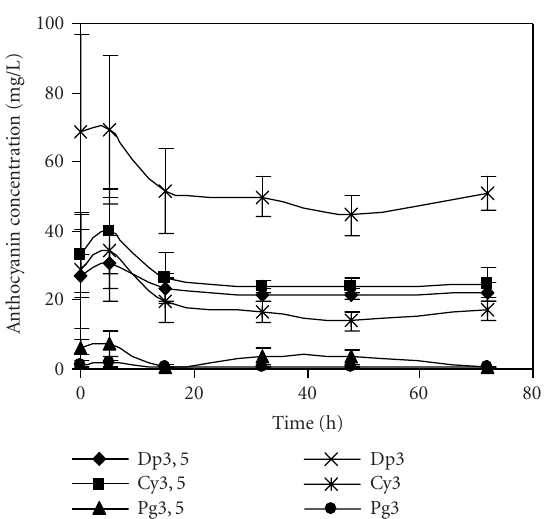
Figure 2. Evolution of concentration of anthocyanins present in the pomegranate juice obtained by squeezing of fruit halves with an electric lemon squeezer and stored for 72 hours at 4 ◦ C. Bars represent standard deviation of 4 replications.